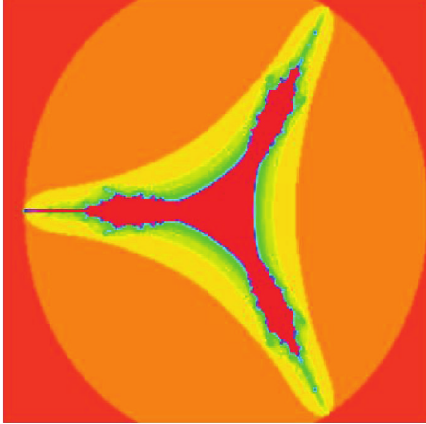
Figure 1: Relative superior tricorn for 𝑠 = 1.0 and 𝑠 󸀠 = 1.0 .